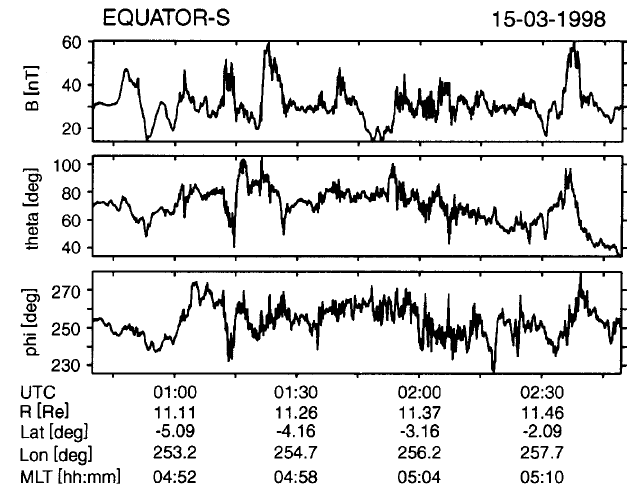
Fig. 5. Large-amplitude irregular variations of the magnetic field (15 March